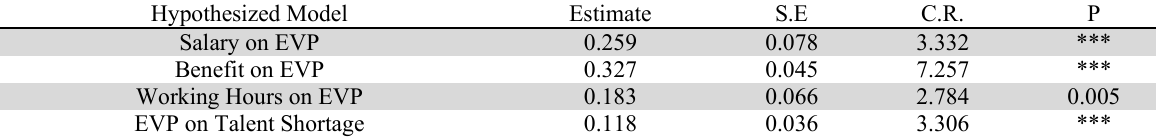
The results of the implementation of SEM for standardised model Hypothesized